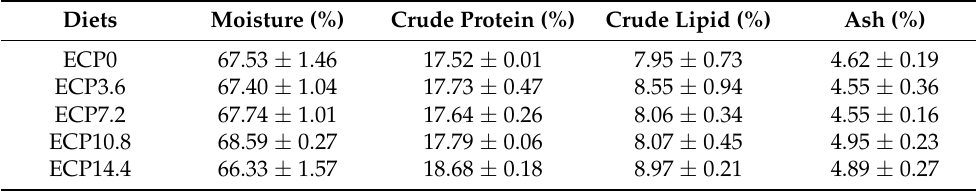
Table 2. Effect of replacing FM with ECP on fish whole-body composition of juvenile largemouth bass ( Micropterus salmoides ) 1 .